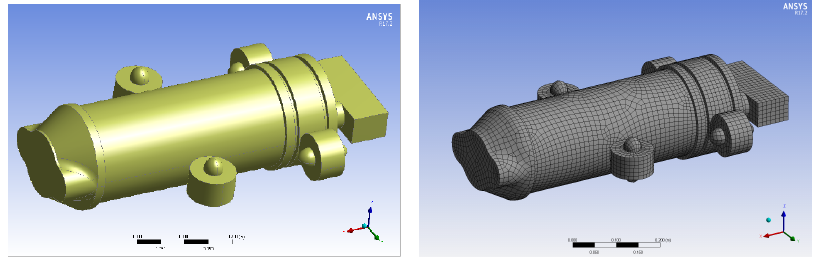
Figure 12. Panel model of the Shark-AUV and meshing of the model.